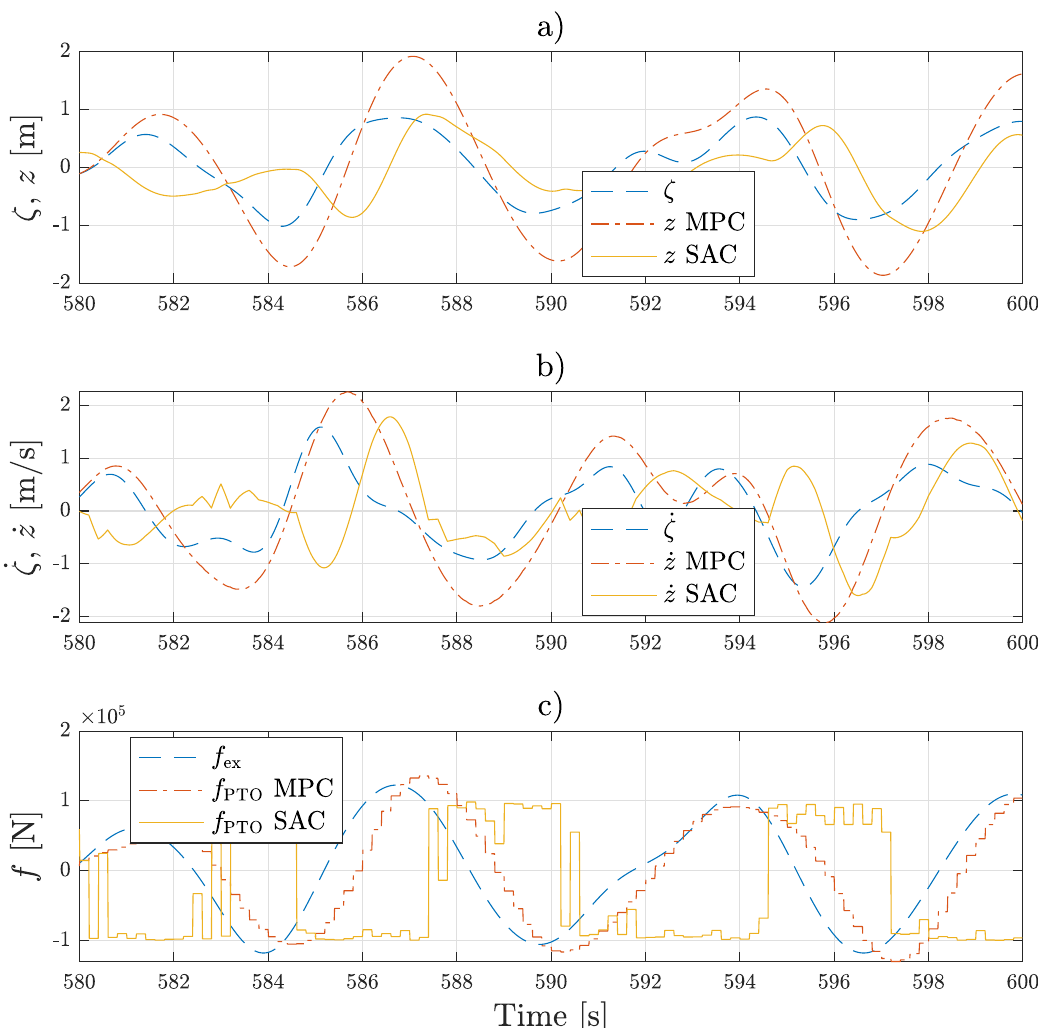
Figure 8. Time variation of the wave elevation and float heave displacement ( a ), wave and heave velocity ( b ) and wave excitation and PTO force ( c ) for the simulation of the WEC in an irregular wave trace with H s = 2 m and T p = 6